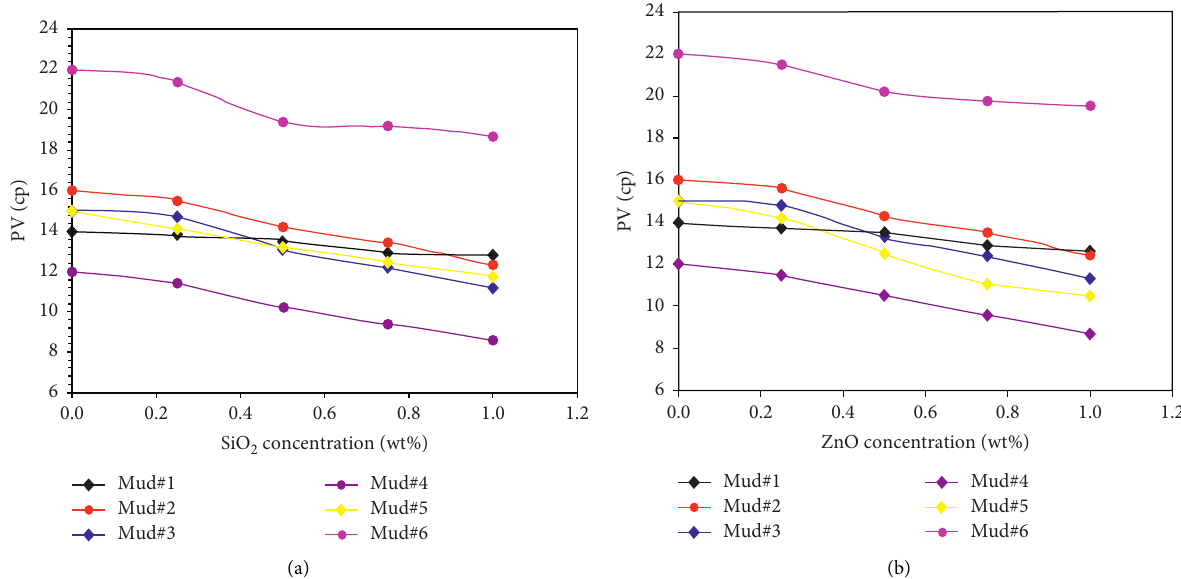
Figure 3: Comparison of plastic viscosity values for the conventional WBM system before and after adding different concentrations of (a) SiO 2 NPs and (b) ZnO